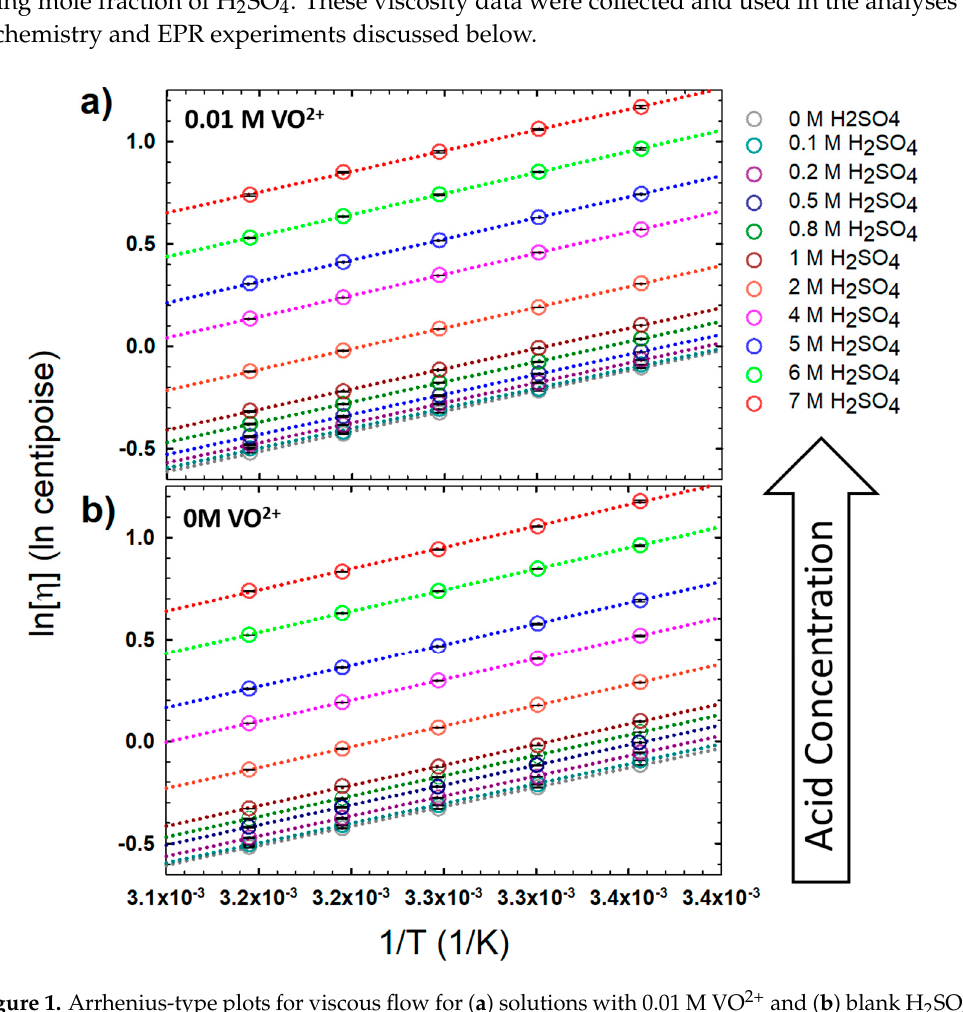
Figure 1. Arrhenius-type plots for viscous flow for ( a ) solutions with 0.01 M VO 2+ and ( b ) blank H 2 SO 4 solutions measured at 25, 30, 35, 40, and 45 °C. Data values in Figure 1 are also shown in Table A3.